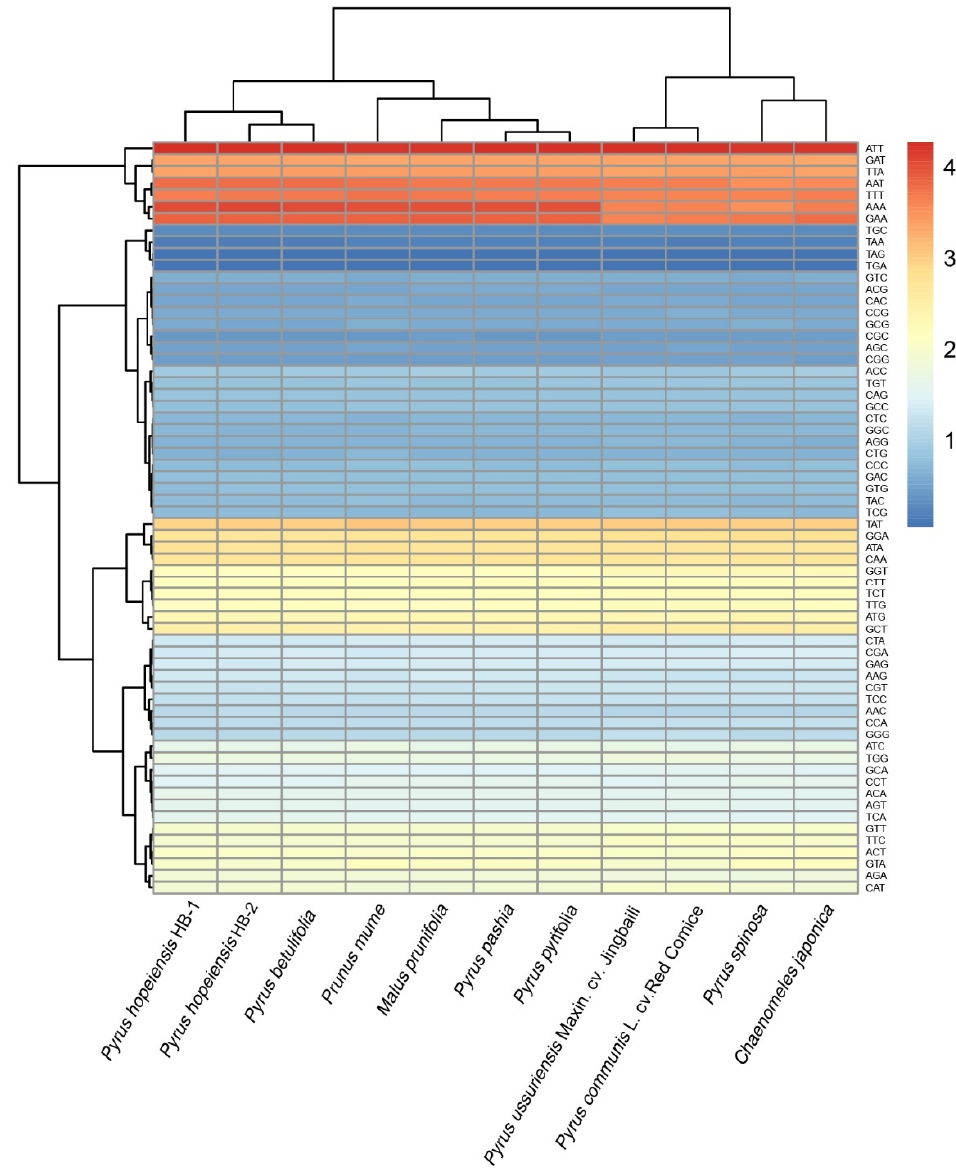
Figure 4. Codon distribution of all merged protein-coding genes. Red indicates a higher frequency and blue indicates a lower frequency.